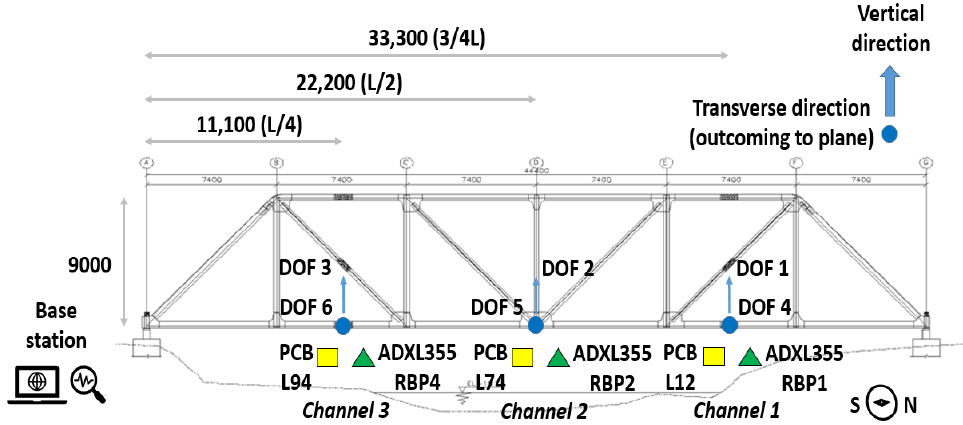
Figure 9. Experimental setup of the testing conducted on a steel structure (lateral view). Dimensions in